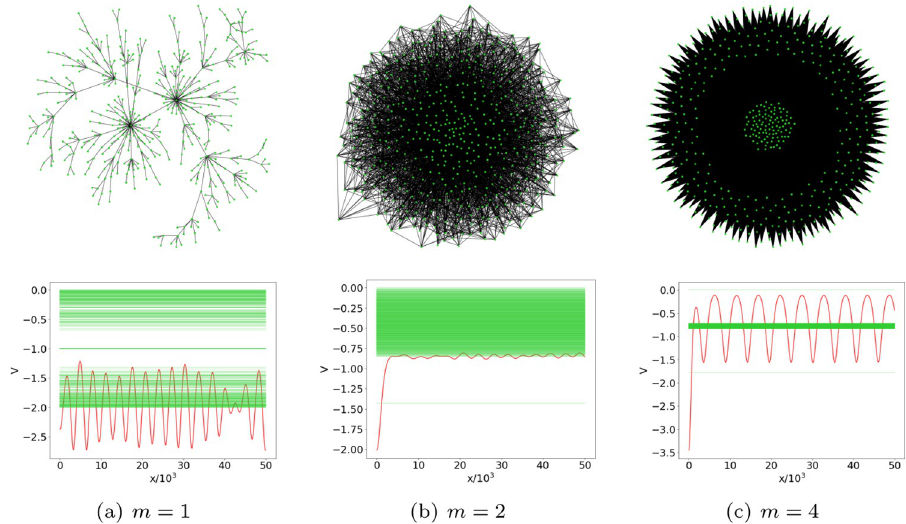
Fig 7. BA ensemble potential for different m values. Ensemble potentials V N = 500 nodes and m connections made by each new node to the existing ones in the graph construction procedure. The figure shows how potentials vary according to the parameter m ranging from 1 to 400, with the left (right) panel reporting the cases of smaller (larger) m